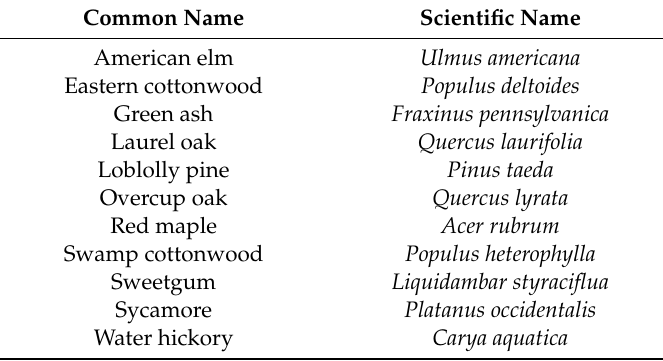
Table 2. Timber species other than cypress-tupelo ( Taxodium–Nyssa species ) present on tracts classified as “mixed”. Mixed tracts contained at least two-thirds composition of one or more of the listed species below. Other vegetation (e.g., shrubs, vines, and herbaceous plants) were present, but not